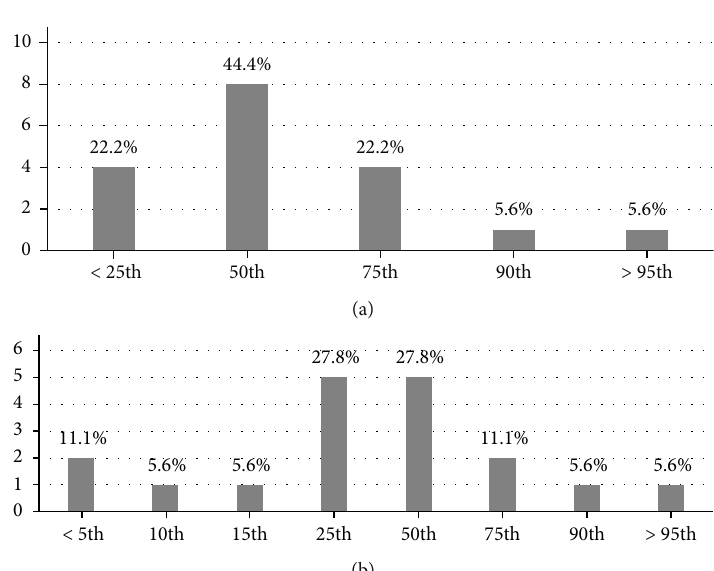
Figure 3: (a) Weight percentile. (b) Height